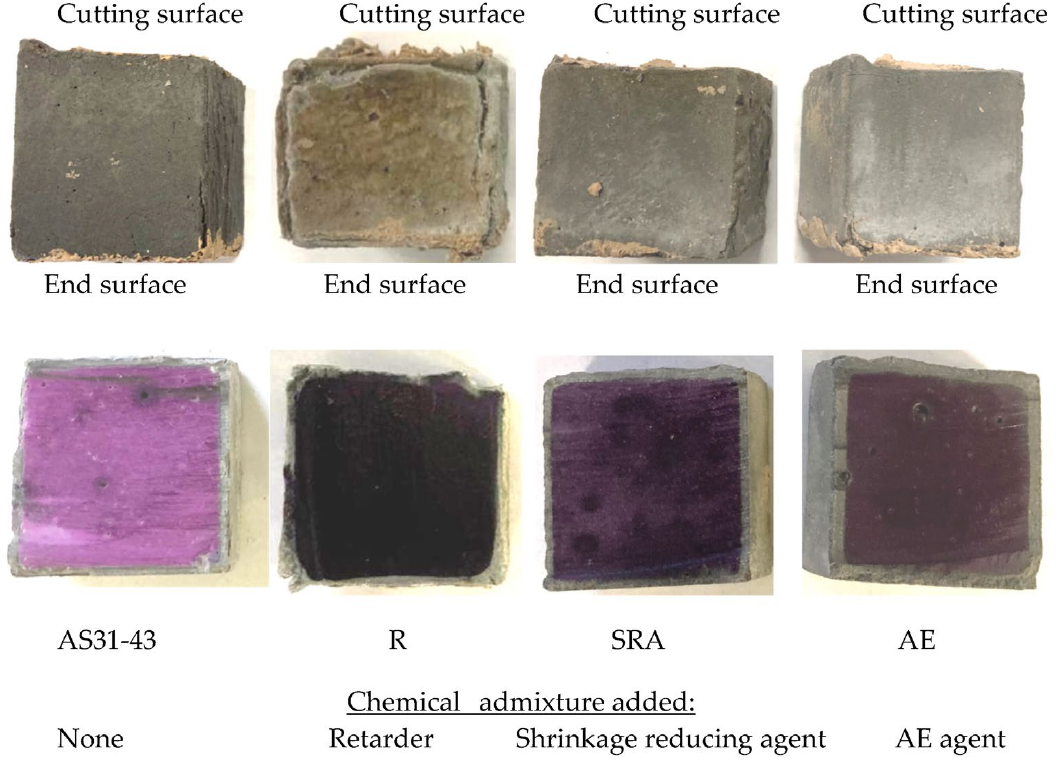
Figure 10. Appearance (upper row) and coloring (upper row) of the specimens (AS/F = 0.40) using different chemical admixtures after 84 - day sulfuric acid immersion .